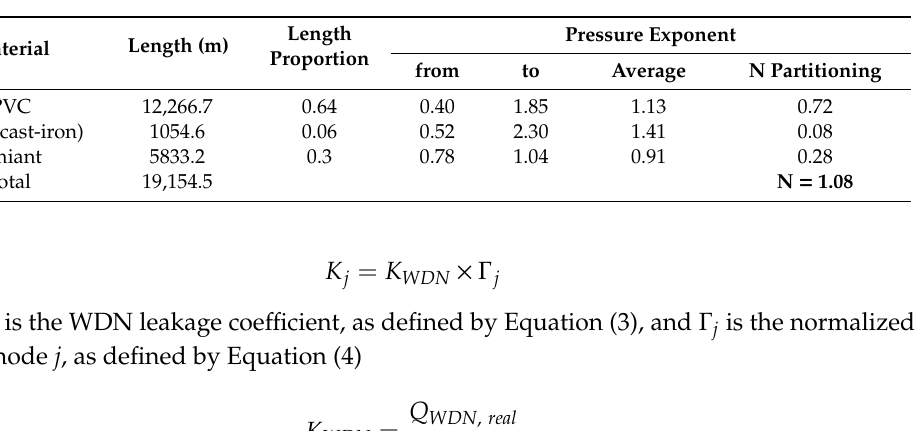
Table 2. Estimation of pressure exponent (N) based on partitioning of di ff erent materials’ N according to their